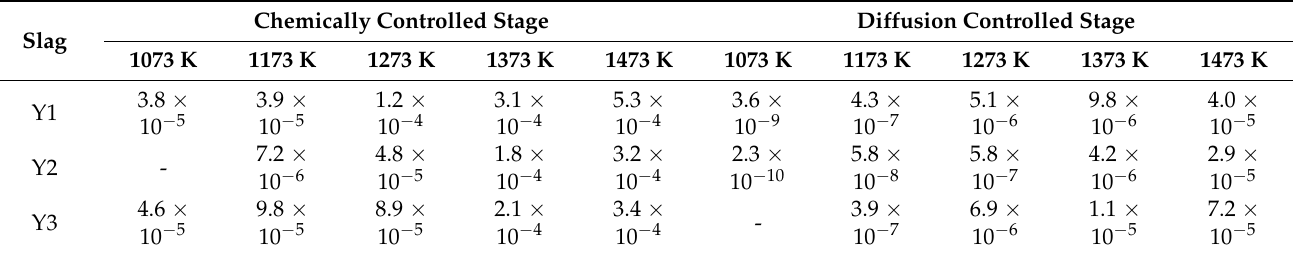
Table 5. Experimentally determined reaction rate